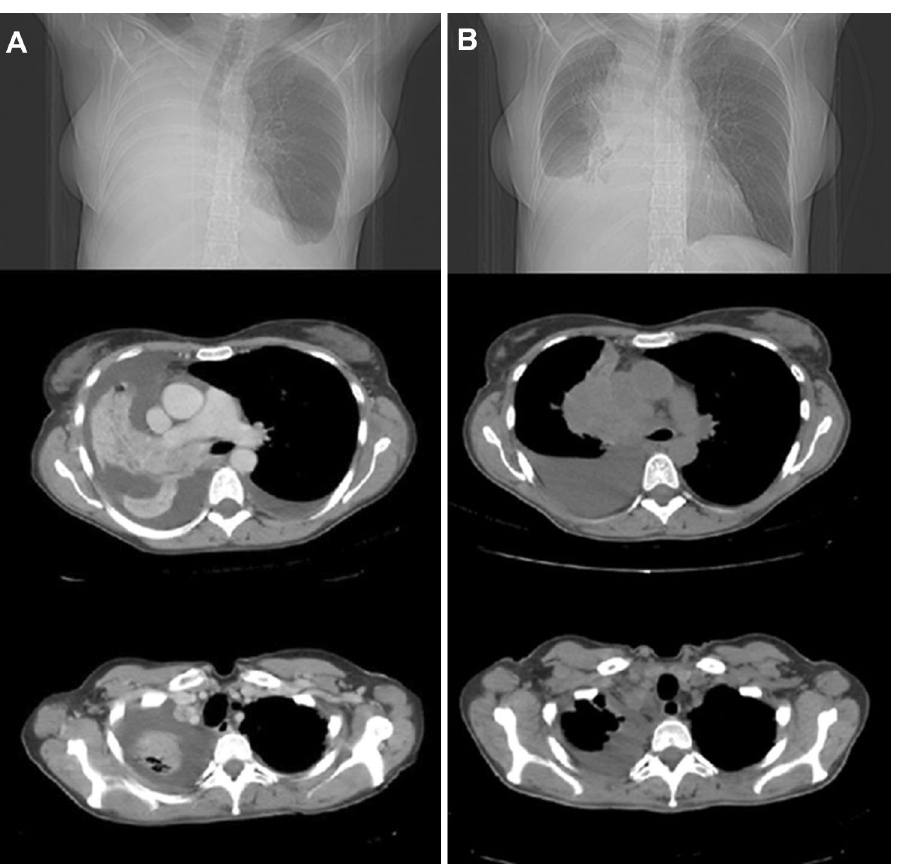
Figure 2. Chest X-ray and CT scan of a patient with locally advanced non-small cell lung tumor before ( A ) and after ( B ) accelerated-hypofractionated radiotherapy (20 Gy in four fractions). The patient reported complete response of dyspnea three days after the